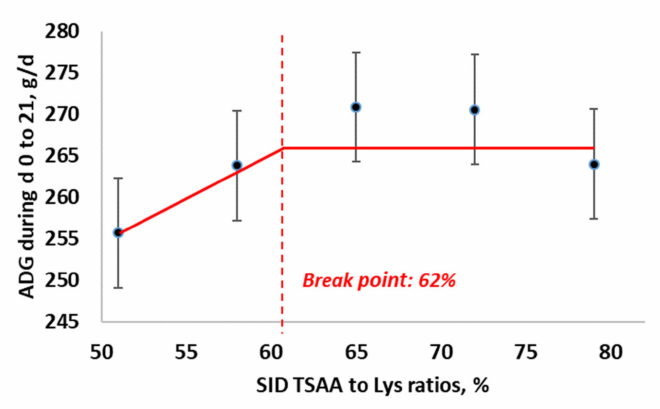
Figure 3. Broken-line linear ascending model for estimation of optimal SID TSAA to Lys ratio in nursery pigs under ABF for average daily gain from d 0 to